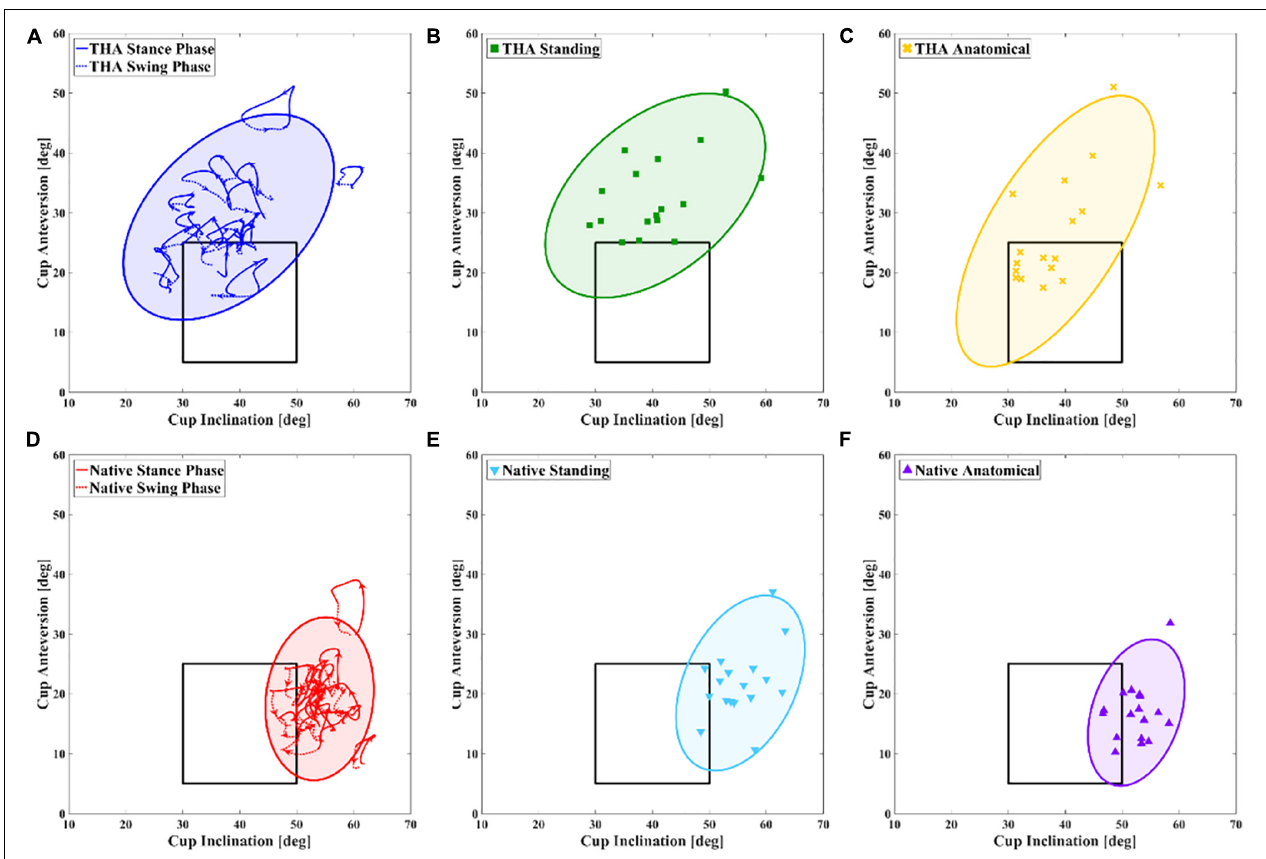
FIGURE 3 | Distributions of different acetabular orientations in total hip arthroplasty (THA) (A–C) and native hip side (D–F) for each unilateral THA patient are shown. Dynamic functional angles in level walking, static functional angles in standing position, and anatomical angles are shown. The blue, green, and yellow 95% group ellipses represent distribution of measurements using different definitions in the THA side, while red, light blue, and violet 95% group ellipses represent distribution of measurements using different definitions in the contralateral native